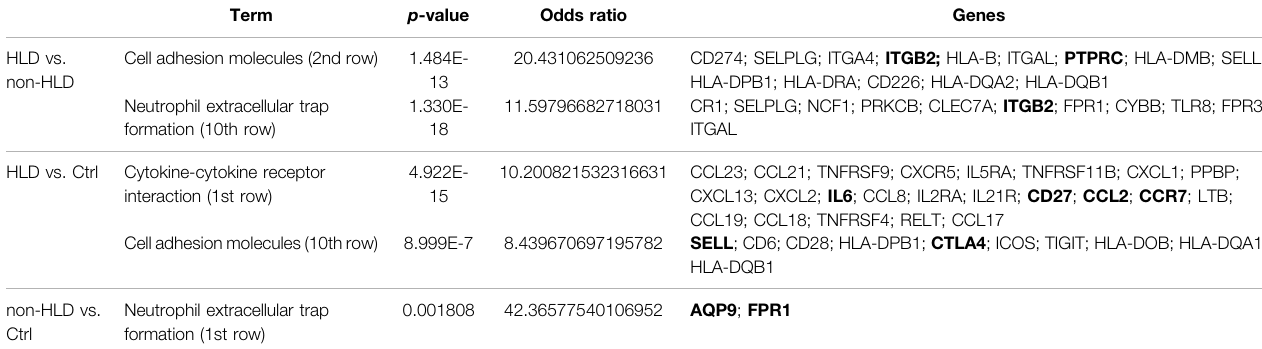
TABLE 1| Pathwayanalysisforcommonly upregulatedprobesineach analysisgroupand theirrespective p -values,oddsratio,and predicted enriched proteins withineach pathway (HLD: Hunner ’ s lesion disease; non-HLD, non- Hunner ’ s lesion disease; Ctrl, control). Term p -value Odds ratio Genes